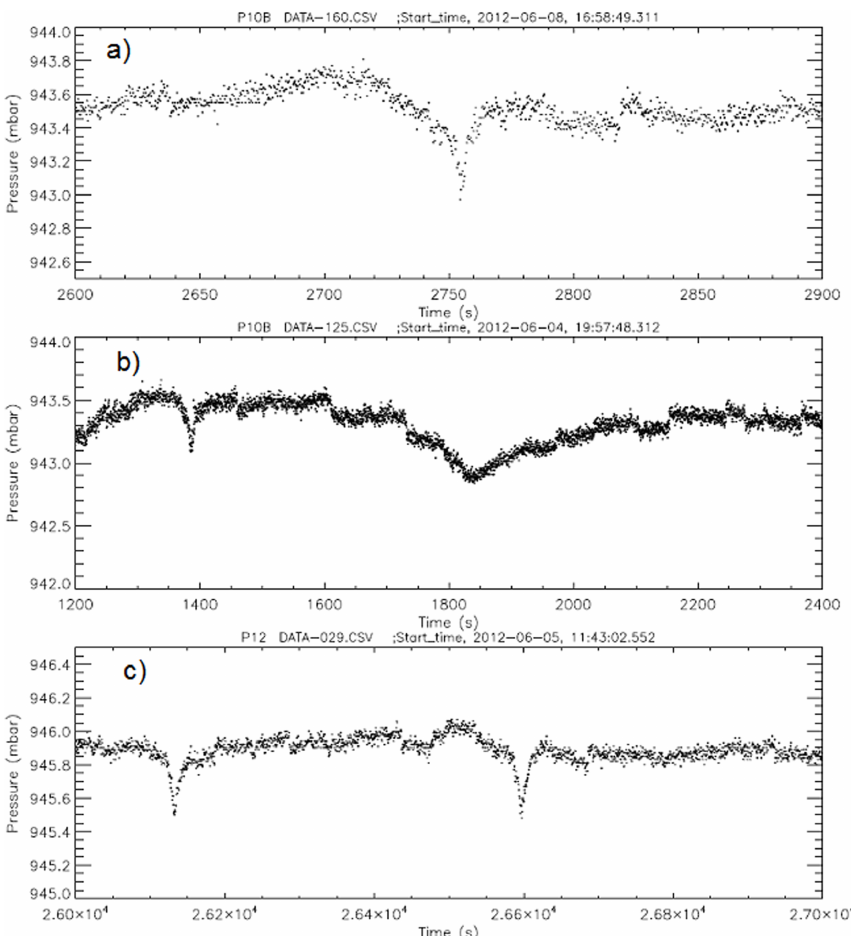
Fig. 9. Some example dust devil signatures. (a) An isolated 30s-wide event with a peak pressure drop of 0.5mbar, (b) a narrow ( ∼ 30s, 0.3mbar) and 400s later a wide (300s, 0.5mbar) feature, the latter presumably due to a large devil at some distance. (c) A sequential pair of similarly-sized devils, each ∼ 300s wide and ∼ 0.4mbar deep and separated by 5000s. Note each plot is scaled differently. Data are uncorrected for sawtooth